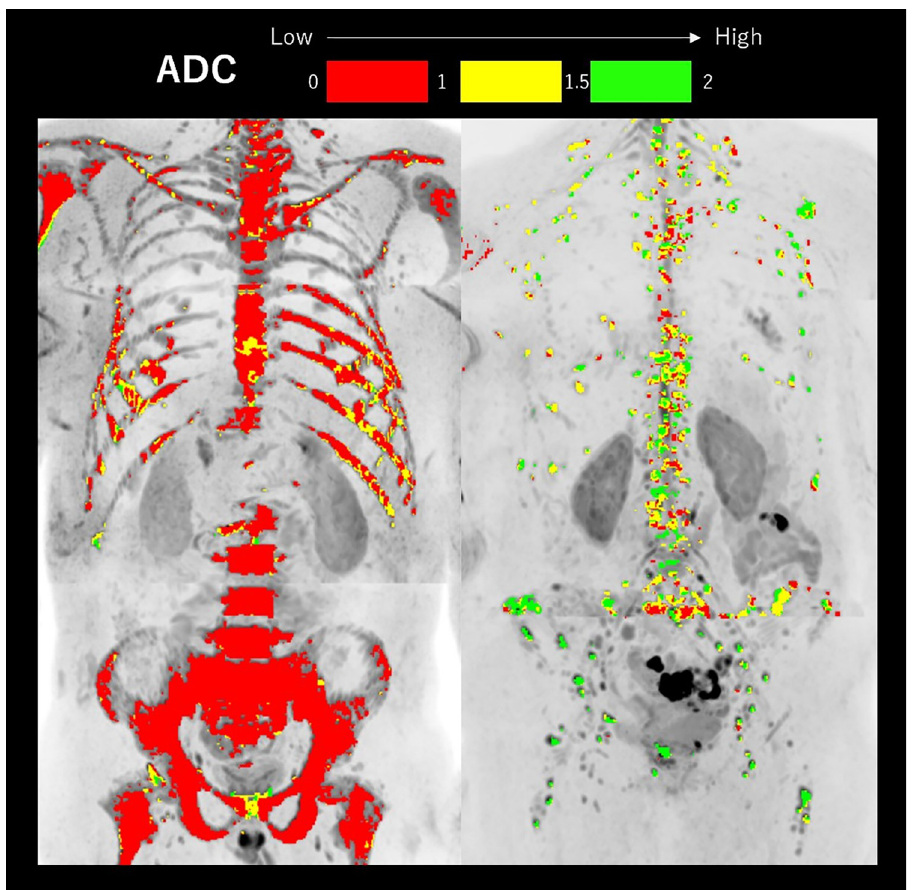
Fig 3. Representative whole-body diffusion-weighted imaging (DWI) for the patient classifications of mobilizer and relatively poor mobilizer. Left image, mobilizer: Whole-body DWI of a 47-year-old man with symptomatic myeloma who had an adequate number of collected CD34 + cells (4.4 × 10 6 CD34 + cells/kg). Median ADC of the total diffusion volume was 0.78 × 10 − 3 mm 2 /s. Right image, relatively poor mobilizer: Whole-body DWI of a 59-year-old woman with symptomatic myeloma who had an inadequate number of collected CD34 + cells (3.8 × 10 6 CD34 + cells/ kg). Median ADC of the total diffusion volume was 1.53 × 10 − 3 mm 2 /s.